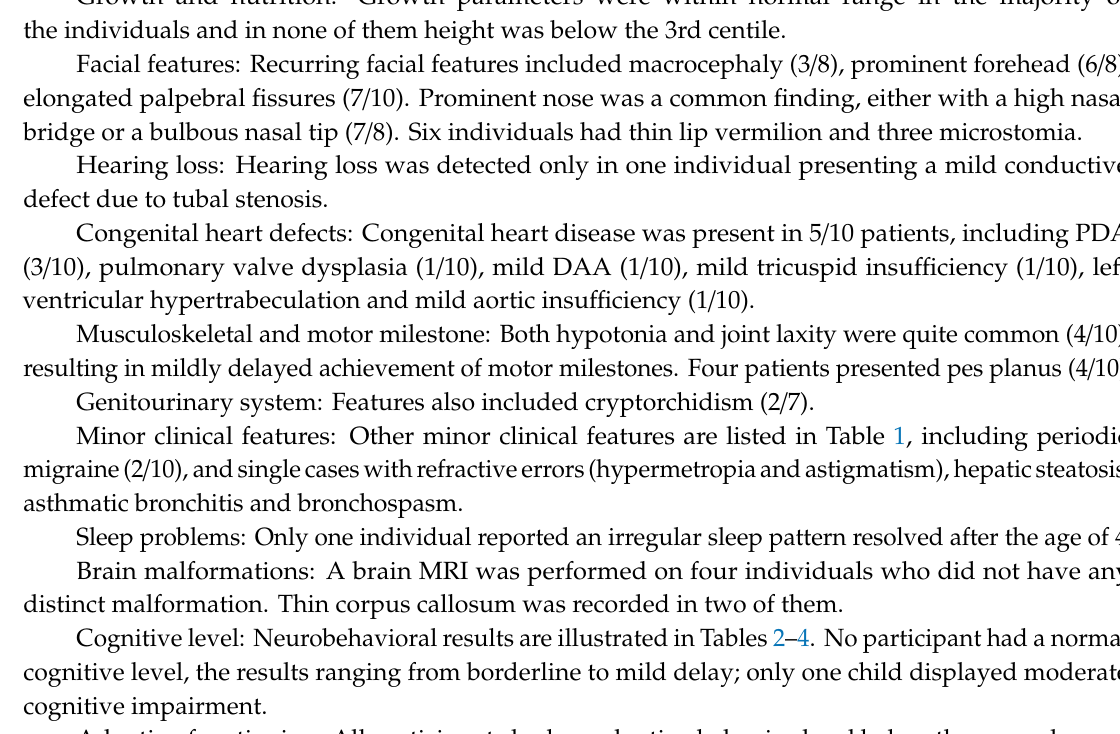
Figure 2. Photographs of patients with a 7q11.23 microduplication (P2, P4, P7, P9). Note macrocephaly, prominent forehead in some patients, elongated palpebral fissures, deep set eyes, palpebral ptosis, high prominent nasal bridge with bulbous nasal tip, short philtrum and thin vermillion of the lips.